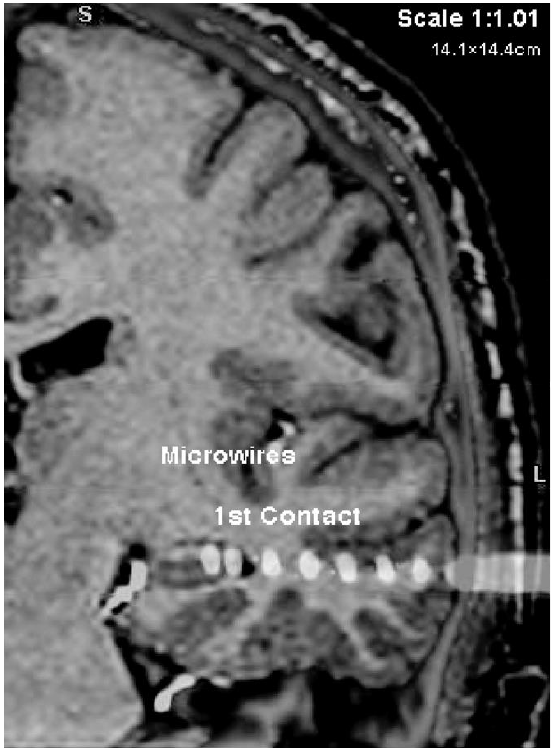
Figure A2. Image of clinical macroelectrode and microwire electrodes to scale. Numbers on the ruler indicate mm of length.